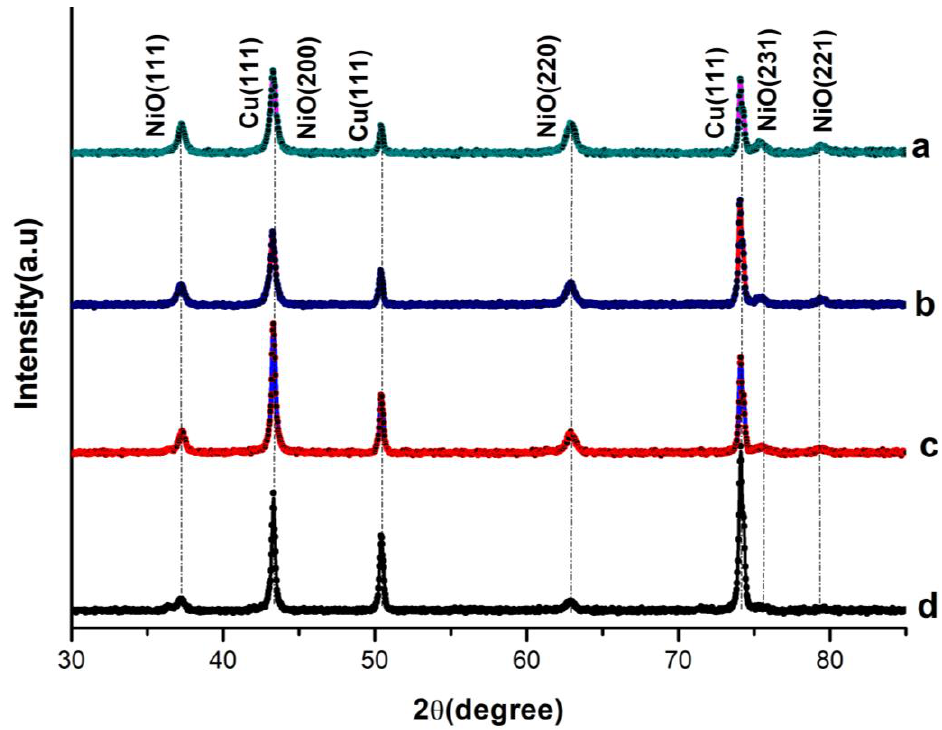
Figure 2. XRD patterns of green synthesized NiO thin films on Cu substrate prepared at rotational speeds (RS) of ( a ) 700 RPM, ( b ) 900 RPM, ( c ) 1100 RPM, and ( d ) 1300 RPM.